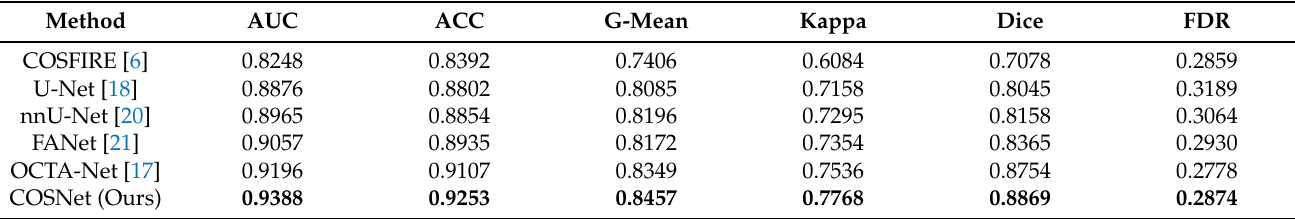
Table 6. Performance comparison on OCTA-6M